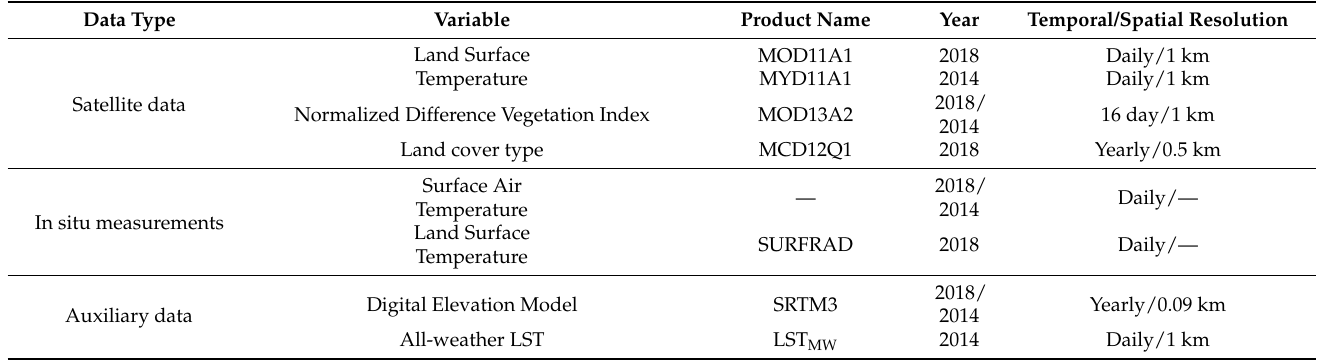
Table 2. Features of the data and products used in this